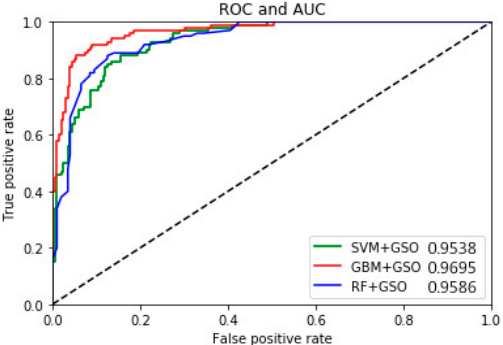
Figure 6. Comparison of receiver operating characteristics for the three-class classification.